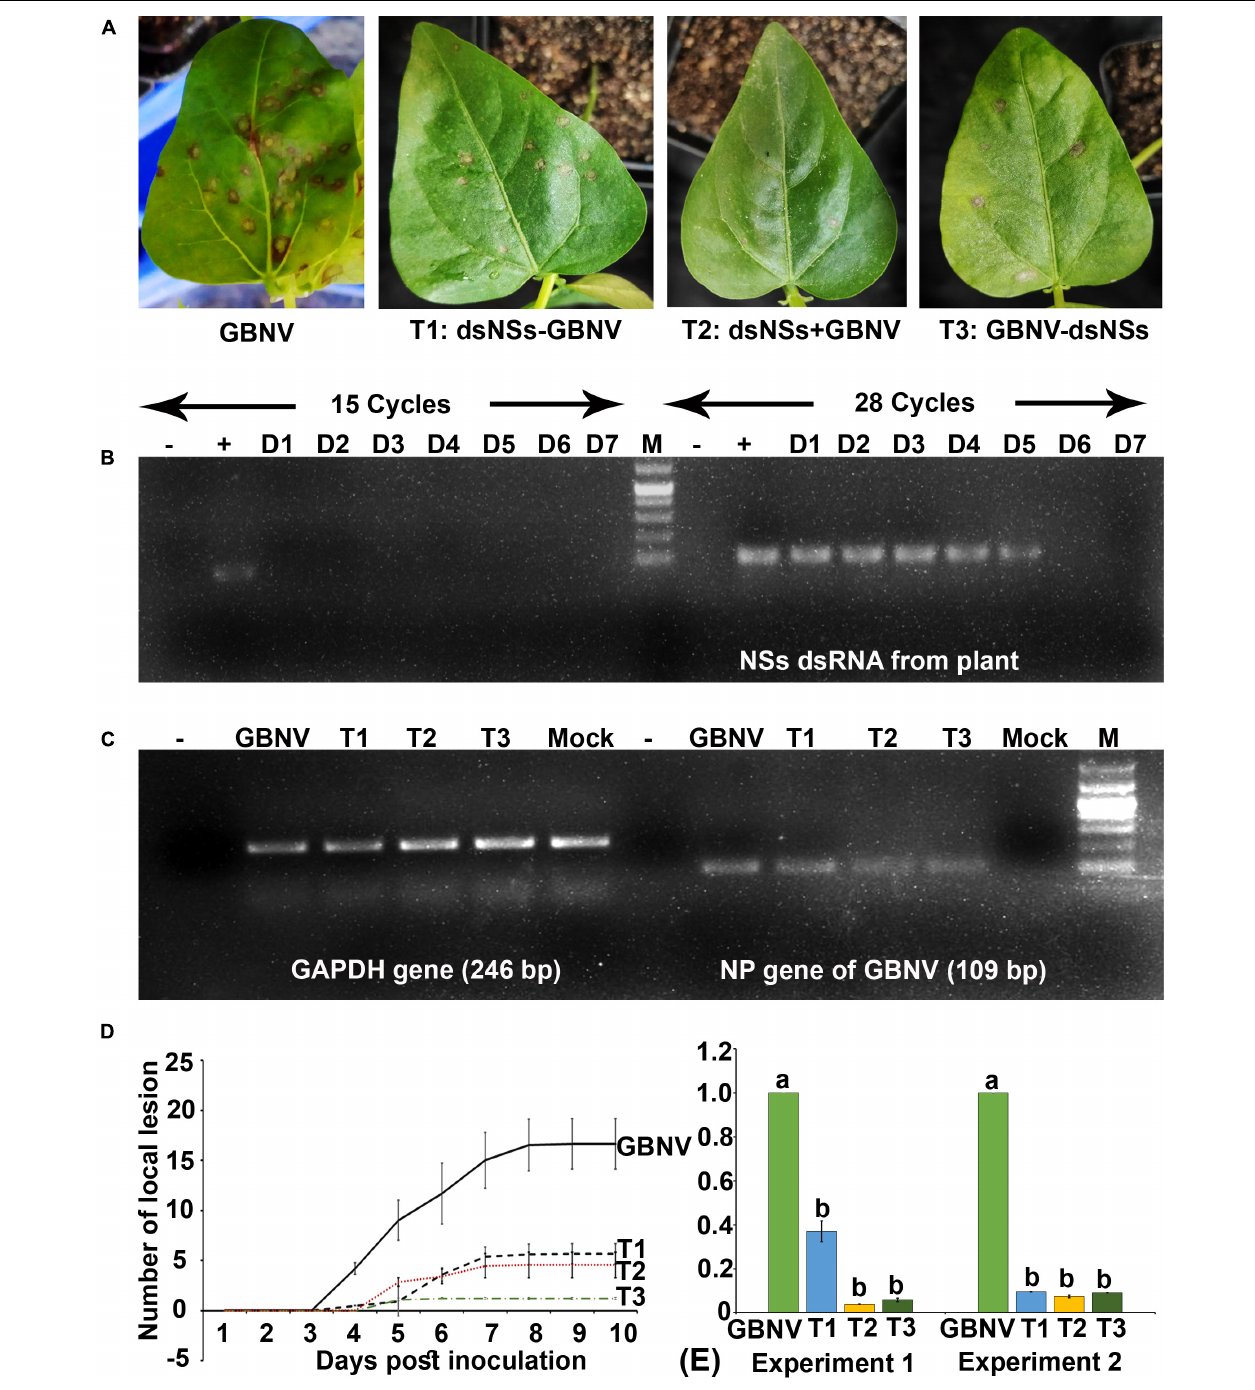
FIGURE 3 | Effect of topically applied dsNSs of GBNV in the cowpea cv. Pusa Komal challenged with GBNV at 6 days post inoculation (dpi). (A) The cowpea leaf showing reduced number of local lesions with T1, T2, and T3 treatment combinations compared to dsNSs untreated control plants. (B) Stability analysis of dsNSs in the absence of GBNV in the local leaves during 1–7 dpi (D1–D7) by sqRT-PCR. (C) Detection of GBNV in the dsNSs-treated plant by sqRT-PCR of NP gene. GAPDH was taken as internal control. (D) Reduction of the progression of local lesions in the three treatments (T1, T2, and T3) as compared to untreated GBNV inoculated control plants. (E) qRT-PCR showing significant reduction ( p ≤ 0.05) of GBNV titer in all the three treatment combinations. Different letters indicate statistically significant difference ( p ≤ 0.05). Two independent experiments were analyzed using GAPDH gene as endogenous reference control. –, reagent control; +, Plasmid of NSs clone (Positive control); Mock, buffer inoculated healthy plant; M, DNA mark 1 kb plus DNA ladder (G-Biosciences, United States).